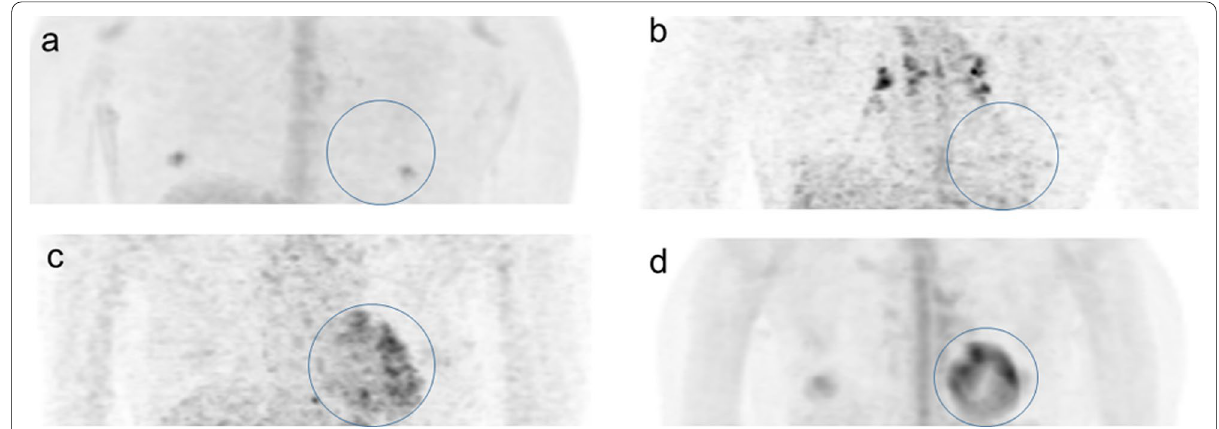
Fig. 1 Myocardial visual quality on Ki images using a 4-point scale: 0 ( a , circle), myocardium not visible; 1 ( b , circle), poor lesion conspicuity; 2 ( c , circle), moderate conspicuity; and 3 ( d , circle), good conspicuity. The visible focal spot in the circle of panel ( a ) indicates the